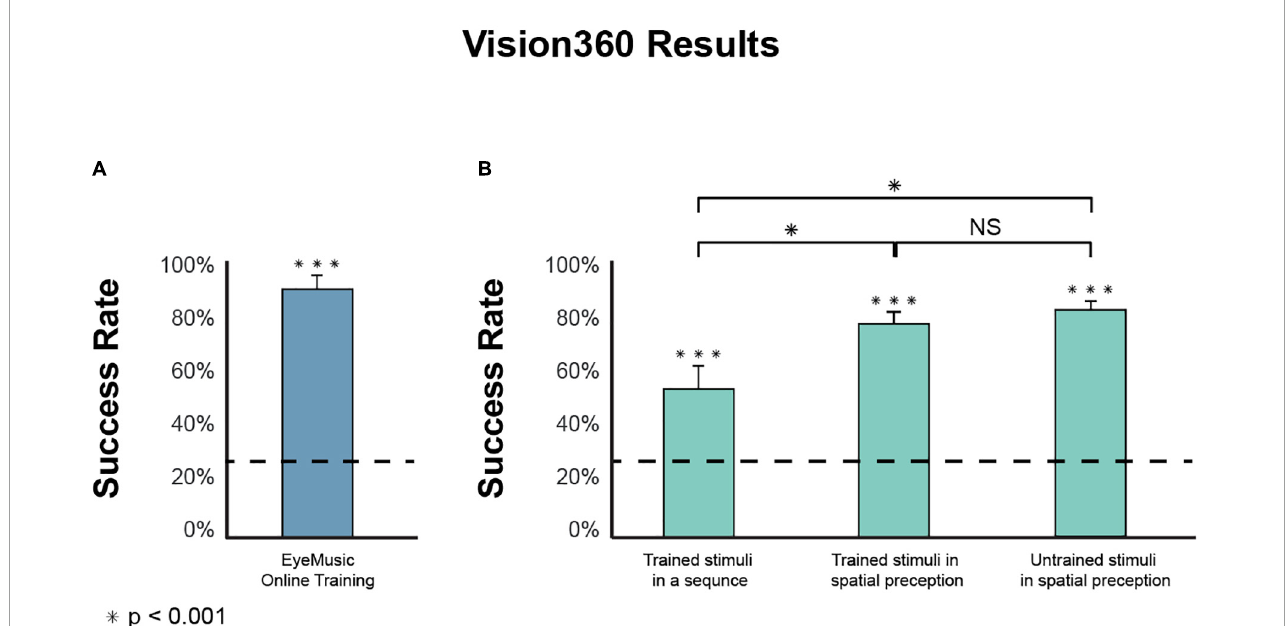
FIGURE4 Experiments results. (A) Participants in the EyeMusic online training had a statistically significant success rate in the final test of 89.3 ± 5.5% [mean correct response ± SD; (A) bars indicate the standard error; dashed line indicates chance level]. (B) Experimental phase tasks’ results are divided into three categories: Recognition of stimulus in a sequence (54.6 ± 16.8%), the success rate of spatially perceiving trained shapes (78.8 ± 12.2%), and recognition of untrained shapes (Generalization) perceived spatially (82.4 ± 14.3%). There was no significant difference between the trained and generalized conditions (W(14) = 22, p = 0.349). However, between the trained sequentially presented stimulus and the trained stimuli presented spatially, there is a significant difference (W(14) = 117, p corr < 0.01), as well as between the stimuli in a sequence compared to the Generalization of stimuli presented spatially (W(14) = 120, p corr < 0.001). ***Means significantly above chance. *Means significantly different between two conditions. NS, not